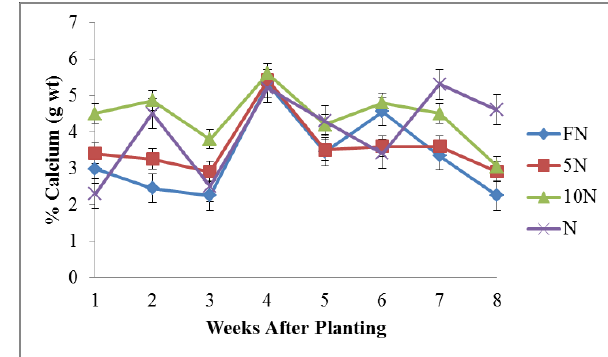
Fig. 6b. The effect of nitrogen nutritional stress on the percent- age calcium content of Zea mays measured at different periods